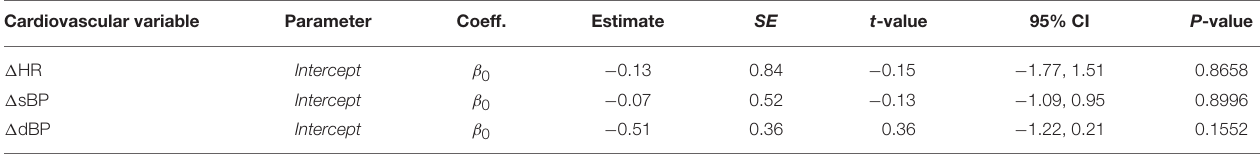
TABLE 3 | Statistical models for 1 HR, 1 sBP, and 1 dBP responses to increase in FES amplitude during PE. Cardiovascular variable Parameter Coeff.